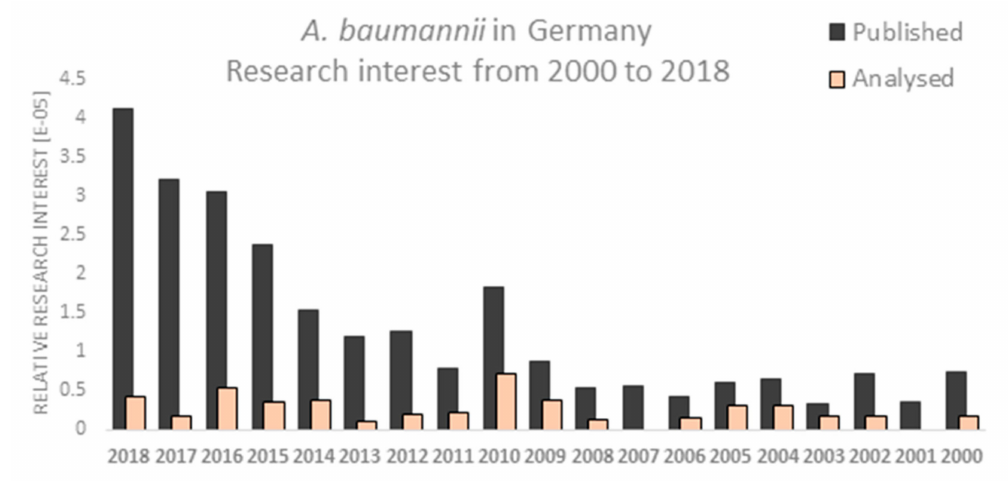
Figure 2. PubMed analysis showing the relative research interest for A. baumannii in Germany from 2000–2018. Publications analyzed in this work a marked